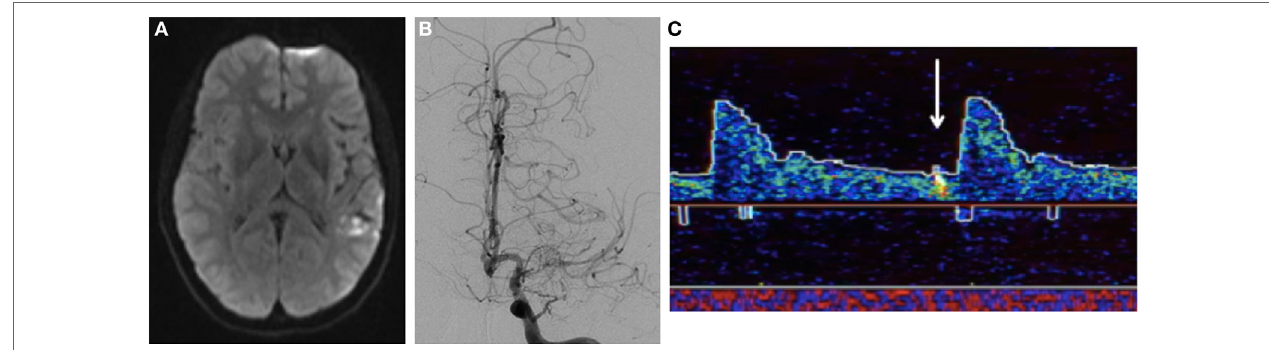
FiGURe 4 | Patient B, a 37-year-old woman with left-sided moyamoya syndrome. (a) Magnetic resonance imaging demonstrates multiple embolic-appearing ischemic infarcts in the left middle cerebral artery (MCA) territory. (B) Cerebral angiogram with severe left ICA stenosis with collateralization. (C) Transcranial Doppler displaying HITS in the left MCA